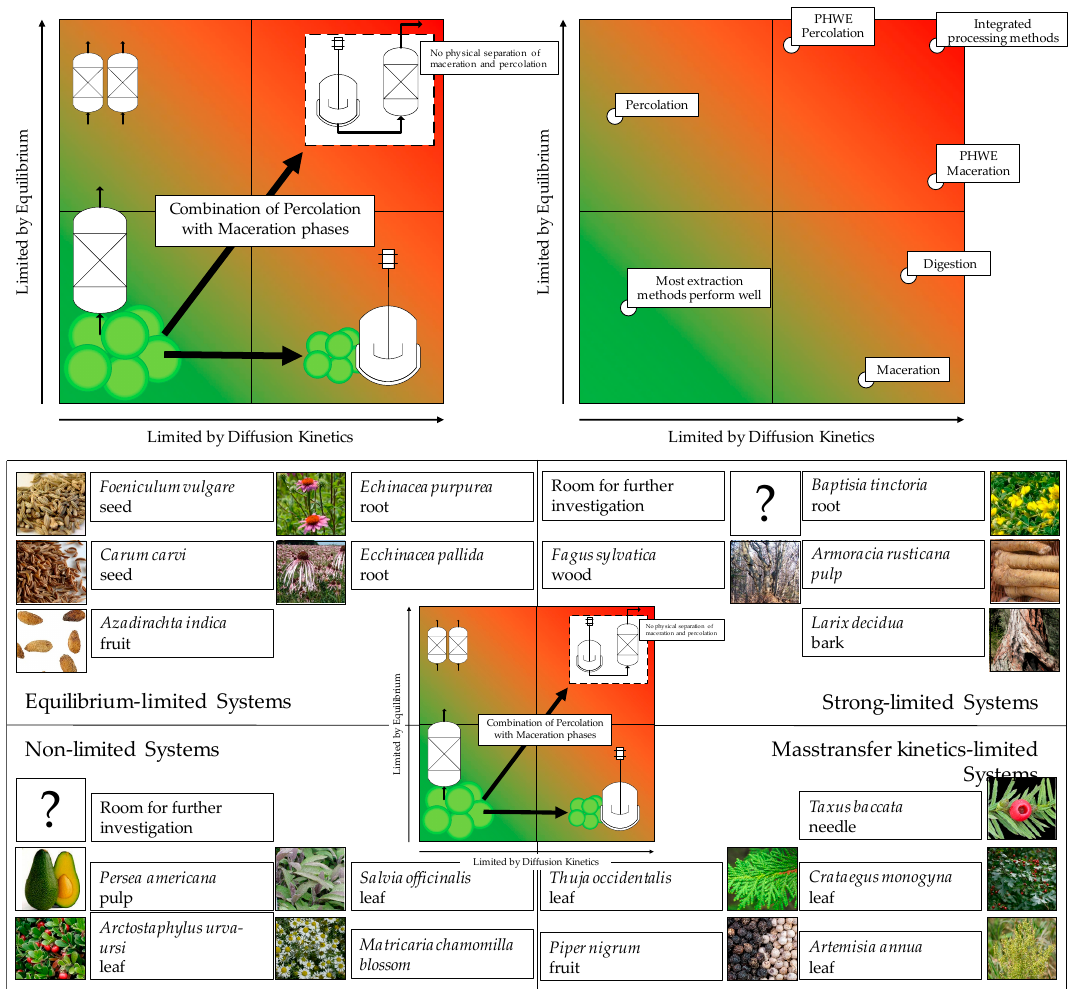
Figure 23. Potential of different extraction methods in handling two basic mass transfer limitations and overview of different characterized plant systems.